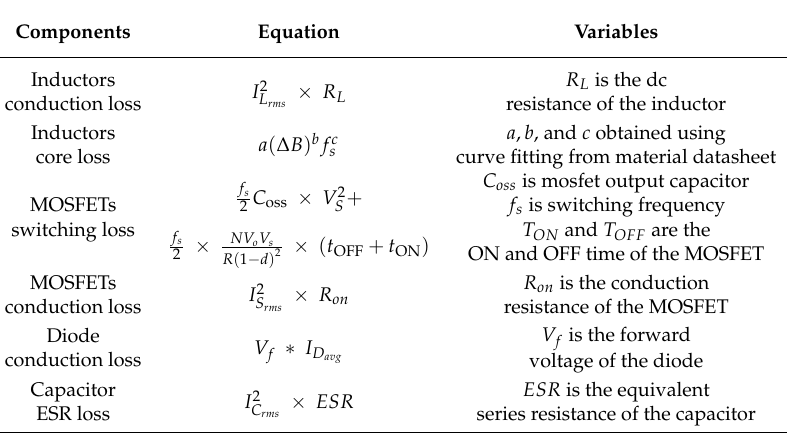
Table 5. Efficiency analysis for